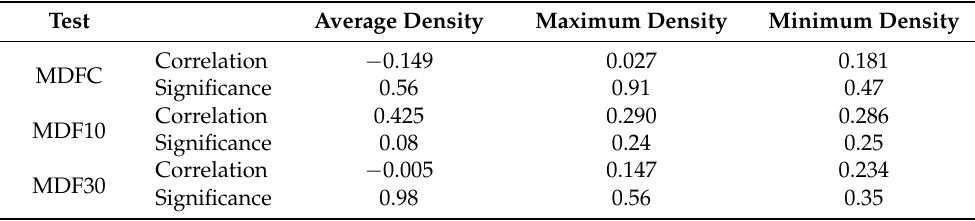
Table 7. Pearson correlation for different density values and internal bond of MDF panels. Test Average Density Maximum Density Minimum Density MDFC